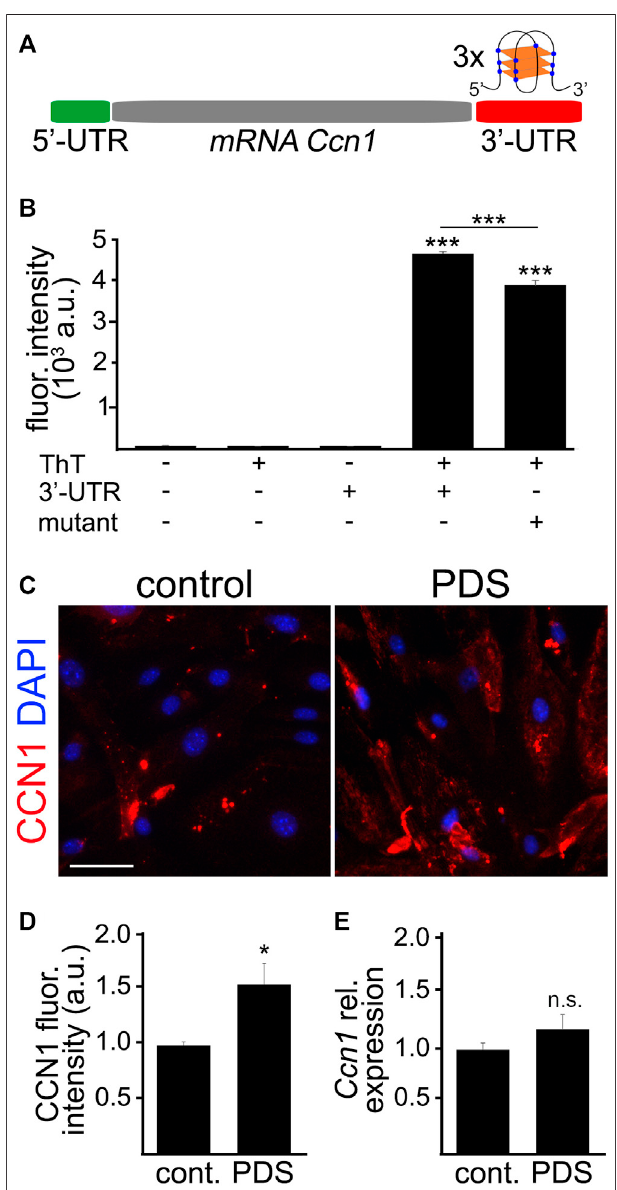
FIGURE6| The3 ′ -UTR Ccn1 mRNAfoldedintoG4s. (A) Schemeofthe mRNA Ccn1 where the 5 ′ -UTR (green) does not contain any potential G4 motif, and the 3 ′ -UTR (red) contains three potential G4 motifs. In the representation of a RNA G4 structure, blue dots indicate Gs and orange rectangles indicate planar rearrangements between Gs. (B) The RNA sequencecontainingthepotentialG4inthe3 ′ -UTR Ccn1 nearthestopcodon (3 ′ -UTR) or the RNA sequence containing the 3 ′ -UTR Ccn1 with a single mutation (mutant), as a negative control, were incubated at 90 ° C for 2 m, and cooled down at room temperature for 2 h. Then, the annealed RNA 3 ′ -UTR and mutant sequences were mixed with a Thio fl avin T (ThT) solution, and the fl uorescence emission wasmeasured.Ascontrolsweused thebufferalone,a ThT solution alone, and the 3 ′ -UTR sequence alone. One-way ANOVA, *** p -value < 0.0001. Data were collected from four independent experiments. (C) CEC isolated from aged (18 – 20 m/o) female mice and cultured were treated with pyridostatin (0.5 µM), or a vehicle (water), for 4 days. CEC were fi xed and stained with antibodies against CCN1 and with the nuclear Hoechst